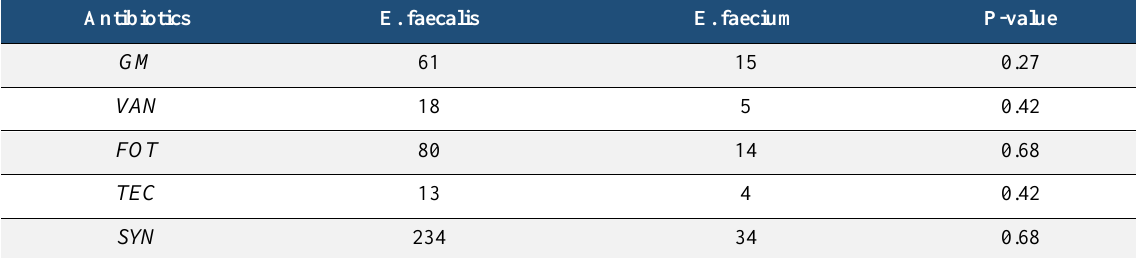
Table 4. The number of resistant samples ( E. faecalis and E. faecium ) to different antibiotics. The last column shows Fisher’s exact test p-values (corrected for multiple testing using FDR) for any difference between the numbers of resistant samples of the two species.